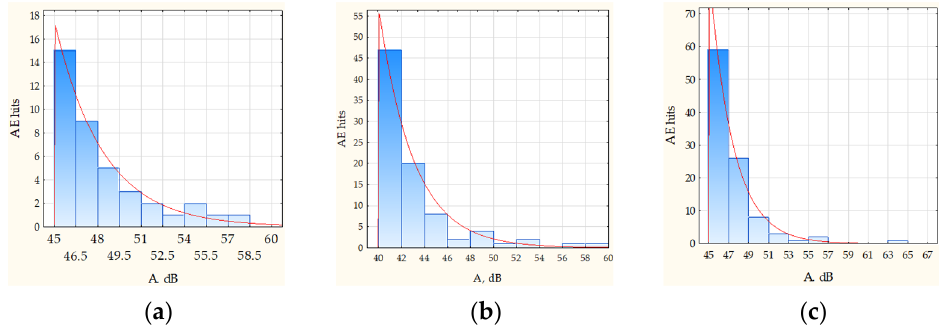
Figure 7. Distribution of AE hits amplitudes for a defect-free specimen at various load values 15 kN ( a ) 30 kN ( b ) 45 kN ( c ). ( a ) 30 kN ( b ) 45 kN ( c ).